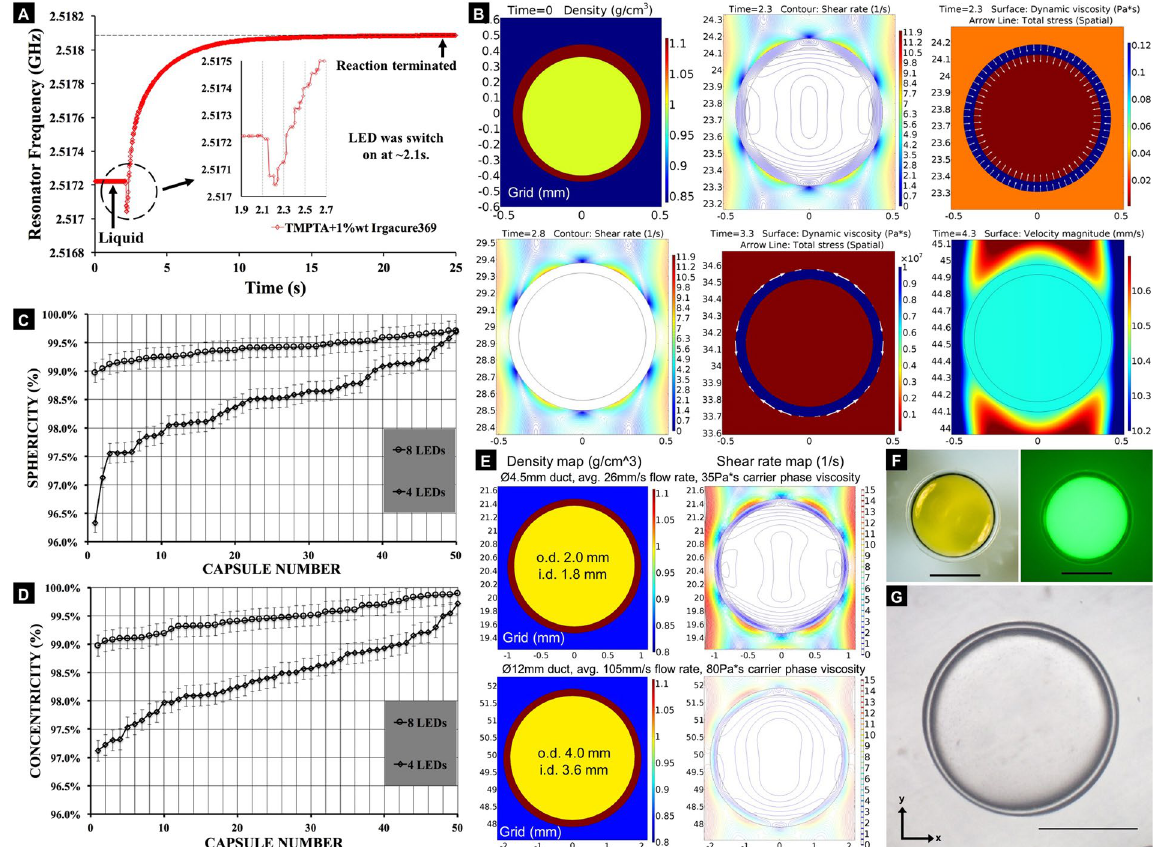
Figure 4. Inertial centralization of curing shells and shell evaluations. ( A ) Microwave resonator frequency changes over time, indicating changes in polymer permittivity. Experimental results obtained during photopolymerisation of TMPTA + 1%wt Irgacure 369, held within a quartz capillary, inside the overall resonator. The UV LED was switched on for 5 second. ( B ) Simulated time sequence images of inertial centralization of DE droplet. Arrow lines are proportional to magnitude. T = 0s, density map, - offset DE droplet; T = 2.3s, shear rate map and viscosity map, centralized DE droplet, the viscosity of TMPTA is 0.122 mPa * s with inwards stress and symmetrical shear rate inside DE; T = 2.8s, shear rate map, shear rate inside DE is zero, while the viscosity is increased to ~0.5 * 106 Pa * s, T = 3.3s, viscosity map, the increase of TMPTA viscosity stopped at 1.0 * 107 Pa * s and the viscous stress only occurred at the oil/TMPTA interface in the normal direction of sphere tangent. T = 4.3s, centralized DE droplet, velocity magnitude map. ( C , D ) Charts of the rank-ordered sphericity and concentricity values, of the TMPTA capsule shells, cured by eight UV LEDs, in comparison to the others cured by four LEDs; average sphericity error = 0.17% and average concentricity error = 0.18%. ( E ) Simulated images of φ 2 mm (top row) and φ 4 mm (bottom row) double emulsion droplets attain concentric and spherical shape in different flow conditions, for the fabrication of different size IFE target shells. ( F ) Images of the TMPTA capsule shell around the core of deionized water with fluorescein sodium salt. Left, dark field image; and right, fluorescent image. ( F ) Confocal image (number of images = 40, z-axis step = 25 um) of TMTPA capsule shell, encapsulating a mixture of deionized water and glycerol, density matched to the TMPTA phase. All scale bars denote 500